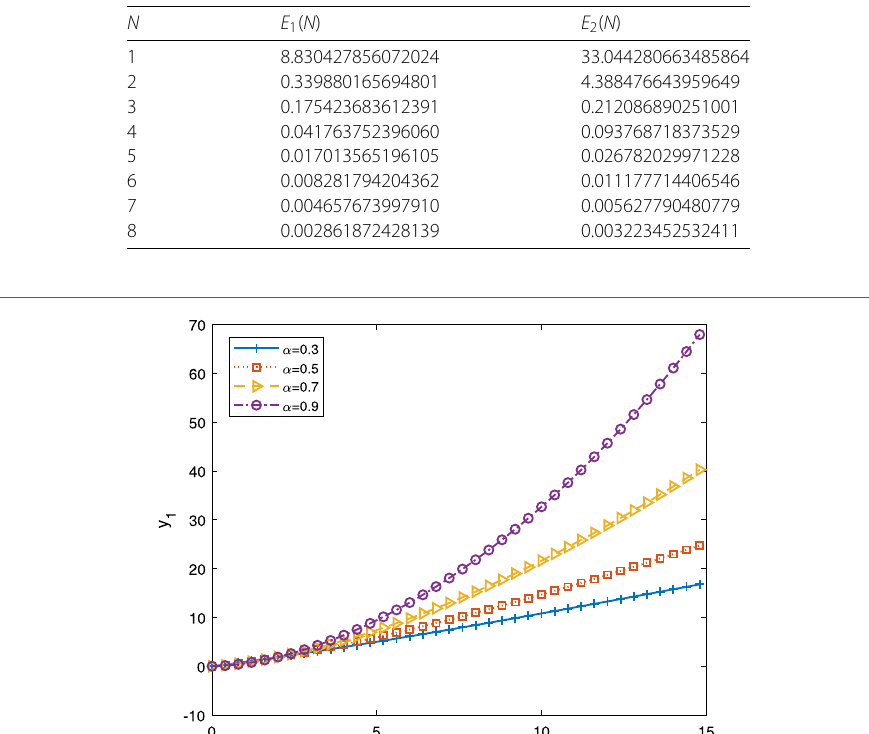
of this system approaches the algebraic linear system y – y 0 = A y + f ( t